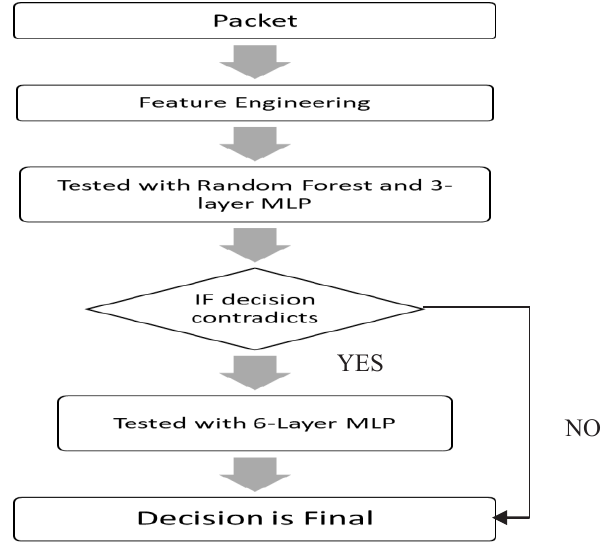
Fig. 4 Proposed Model Architecture of an Anomaly